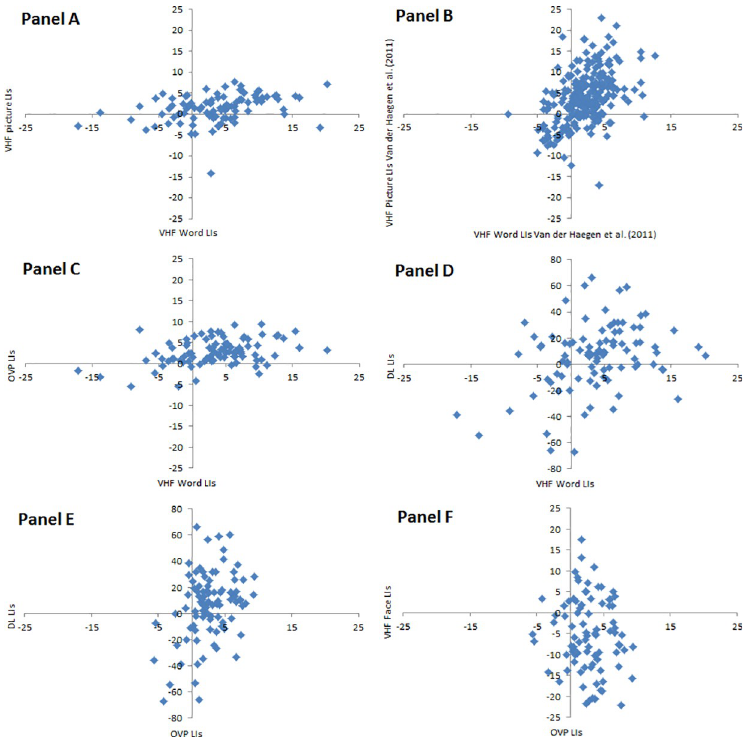
Fig 3. Scatter plots contrasting two tasks. Data points represent individual lateralization indices (LIs) based on reaction times. VHF = Visual Half Field; OVP = Optimal Viewing Position; DL = Dichotic Listening. Note that only the dichotic listening chart has a deviating scale on the y-axis to improve visibility because LIs were based on left/right ear matches and not reaction times.